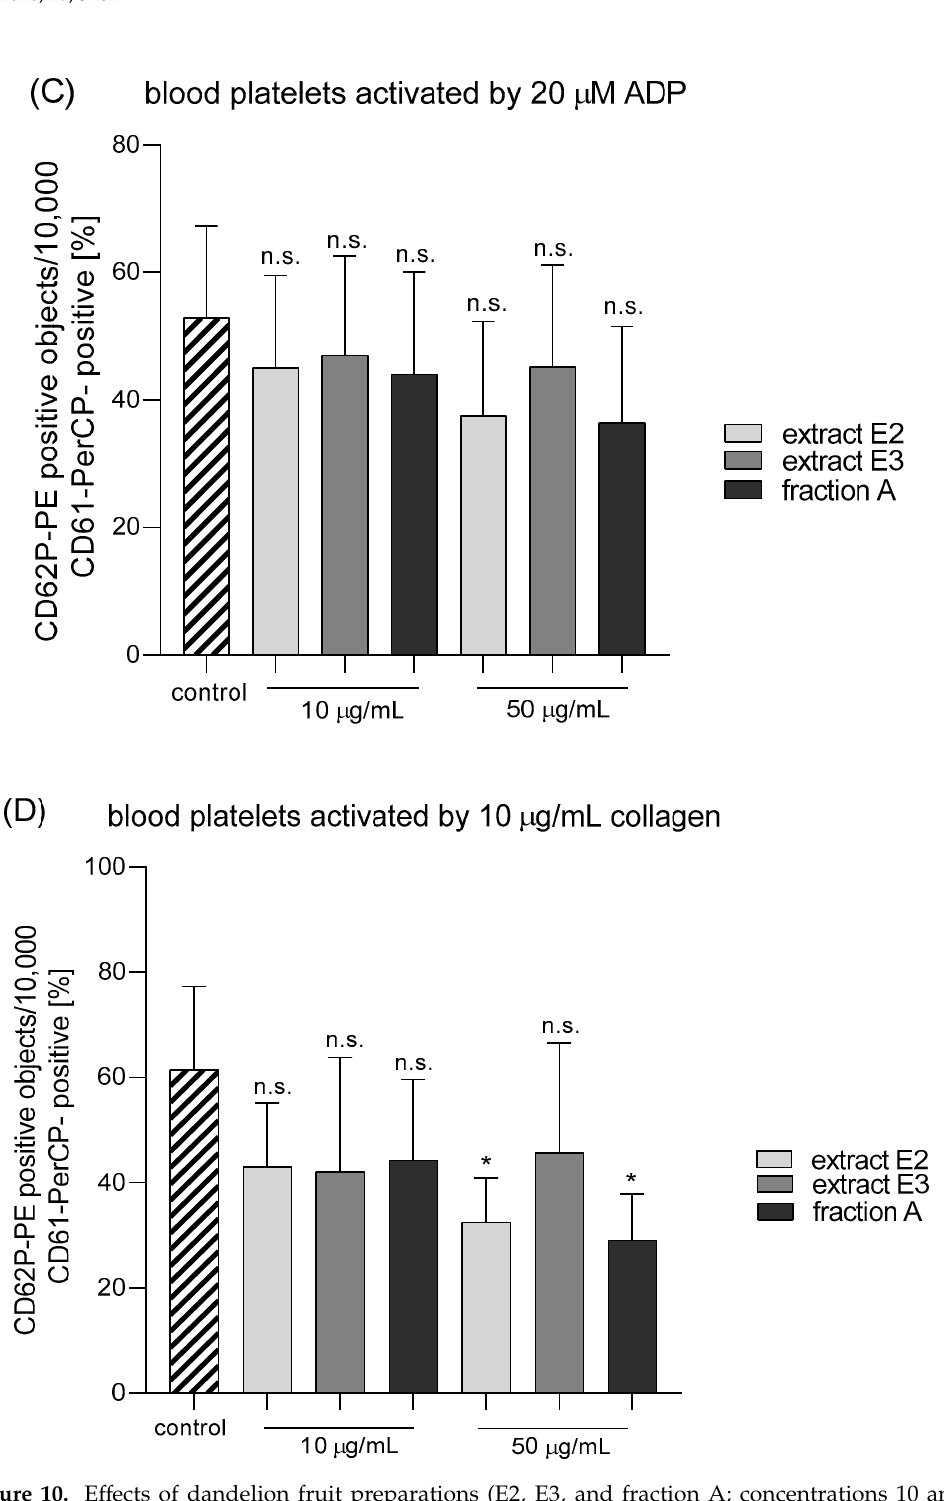
Figure 10. E ff ects of dandelion fruit preparations (E2, E3, and fraction A; concentrations 10 and 50 µ g / mL) on the expression of P-selectin in resting ( A ) or agonist-stimulated blood platelets: 10 µ M ADP ( B ), 20 µ M ADP ( C ) and 10 µ g / mL collagen ( D ) in whole blood samples. The blood platelets were distinguished based on the expression of CD61 / PerCP. For each sample, 10,000 CD61-positive objects (blood platelets) were acquired. For the assessment of P-selectin expression, samples were labeled with fluorescently conjugated monoclonal antibody CD62P. Results are expressed as the percentage values of platelets expressing CD62P. Data are presented as the means ± SE of six healthy volunteers. n.s. p > 0.05; * p < 0.05 (vs. control platelets).